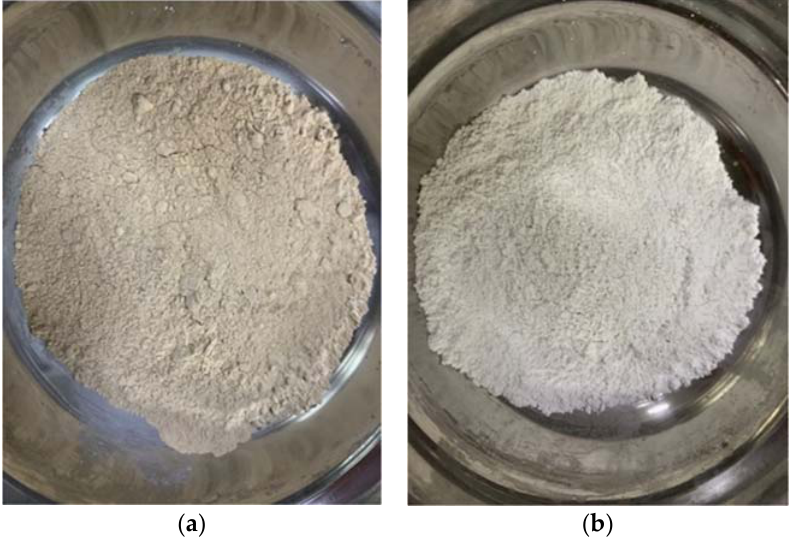
Figure 2. Ordinary kaolin ( a ) and ordinary metakaolin ( b ).